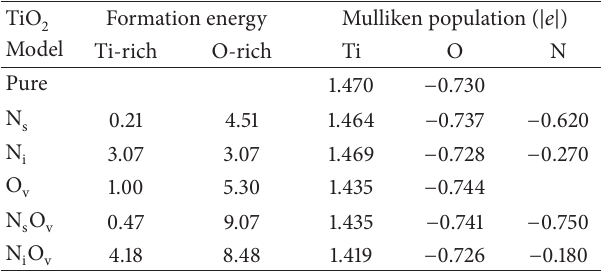
Table 1: Formation energy and average Mulliken population of various defective models of N-doped TiO